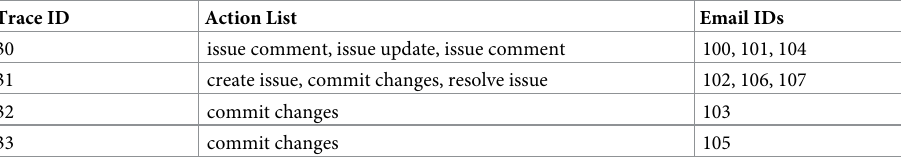
Table 6. Consensus action descriptions for traces